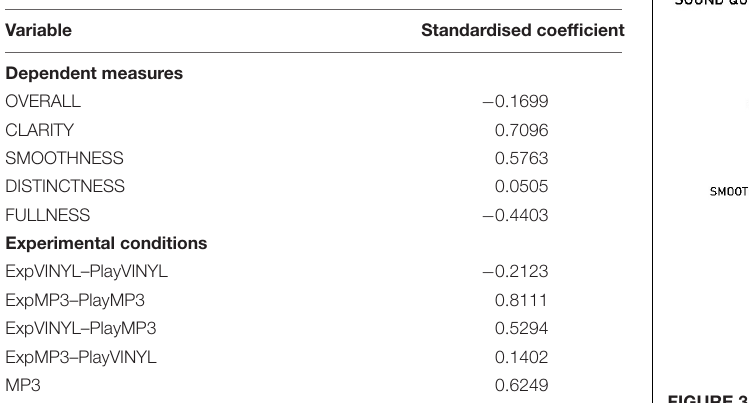
FIGURE 3 | Heliograph showing the estimated multivariate relationship between media and sound quality.